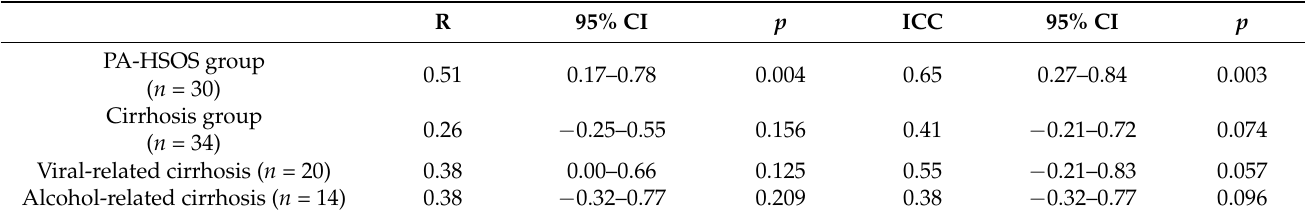
Table 5. Correlation between HVPG and